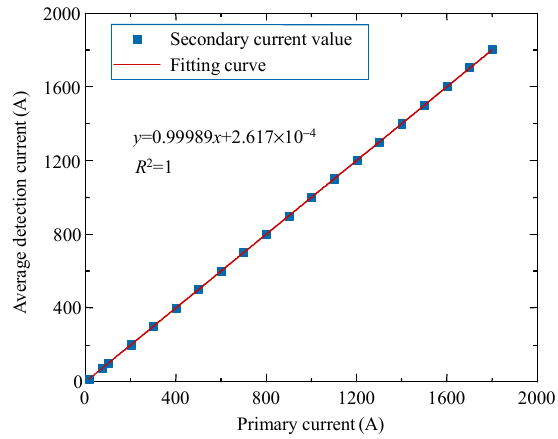
Fig. 6 Output linearity of